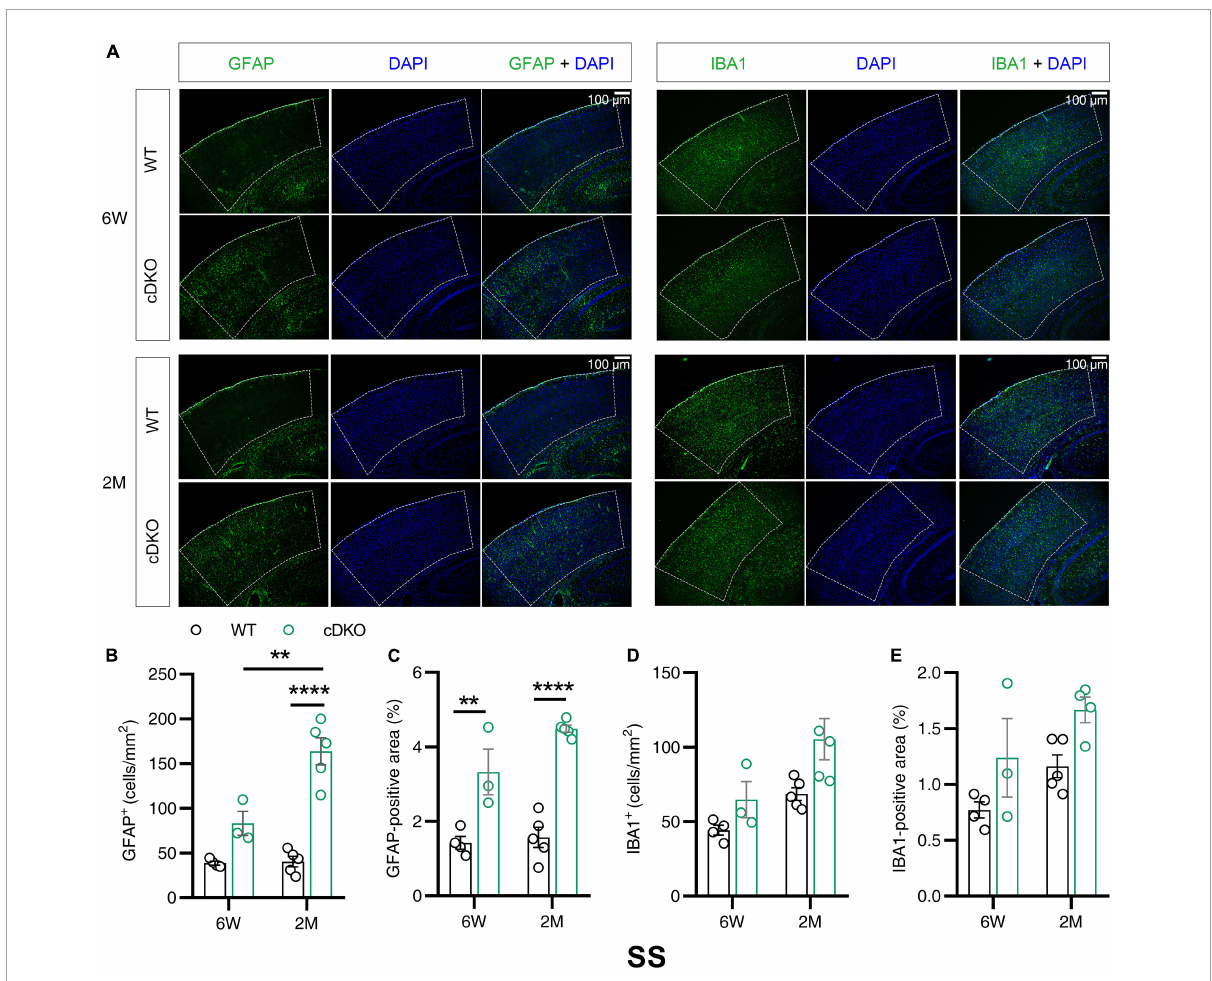
FIGURE2 Astrocyte reactivity, but not the microglial reactivity was increased in the somatosensory cortex (SS) of cDKO mice at 6 weeks of age. (A) Representative images of immunohistochemistry for GFAP and IBA1 of WT (control) and cDKO brains at 6 weeks (6 W) and 2 months (2 M) of age. (B–E) Quantification of GFAP-positive cells (B) , GFAP-positive areas (C) , IBA1-positive cells (D) and IBA1-positive areas (E) in the SS of WT and cDKO mice. Data are presented as the mean ± SEM ( n = 3–5 for each group). One-way ANOVA analysis followed by Turkey’s test, ** p < 0.01, **** p < 0.0001. Scale bar 100 µ